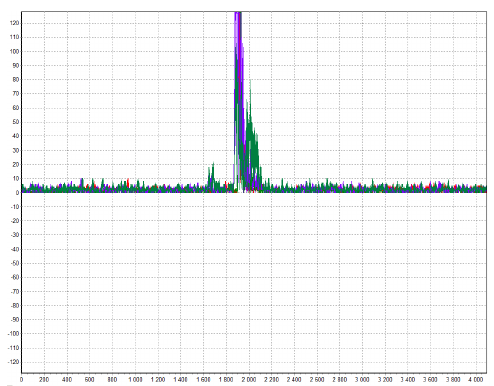
10 16 -10 20 eV. Lines calcula- ·